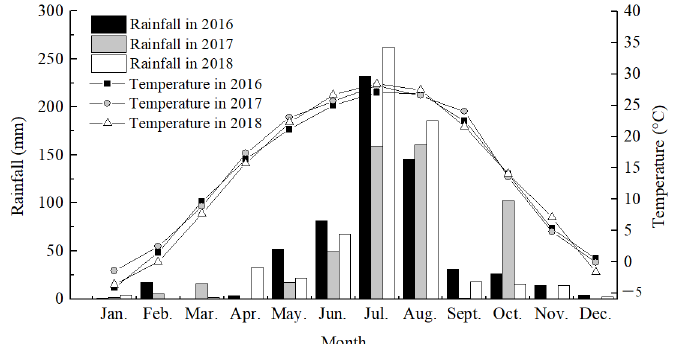
Figure 1. Variations in mean monthly temperature and precipitation of experimental site from 2016 to 2018.